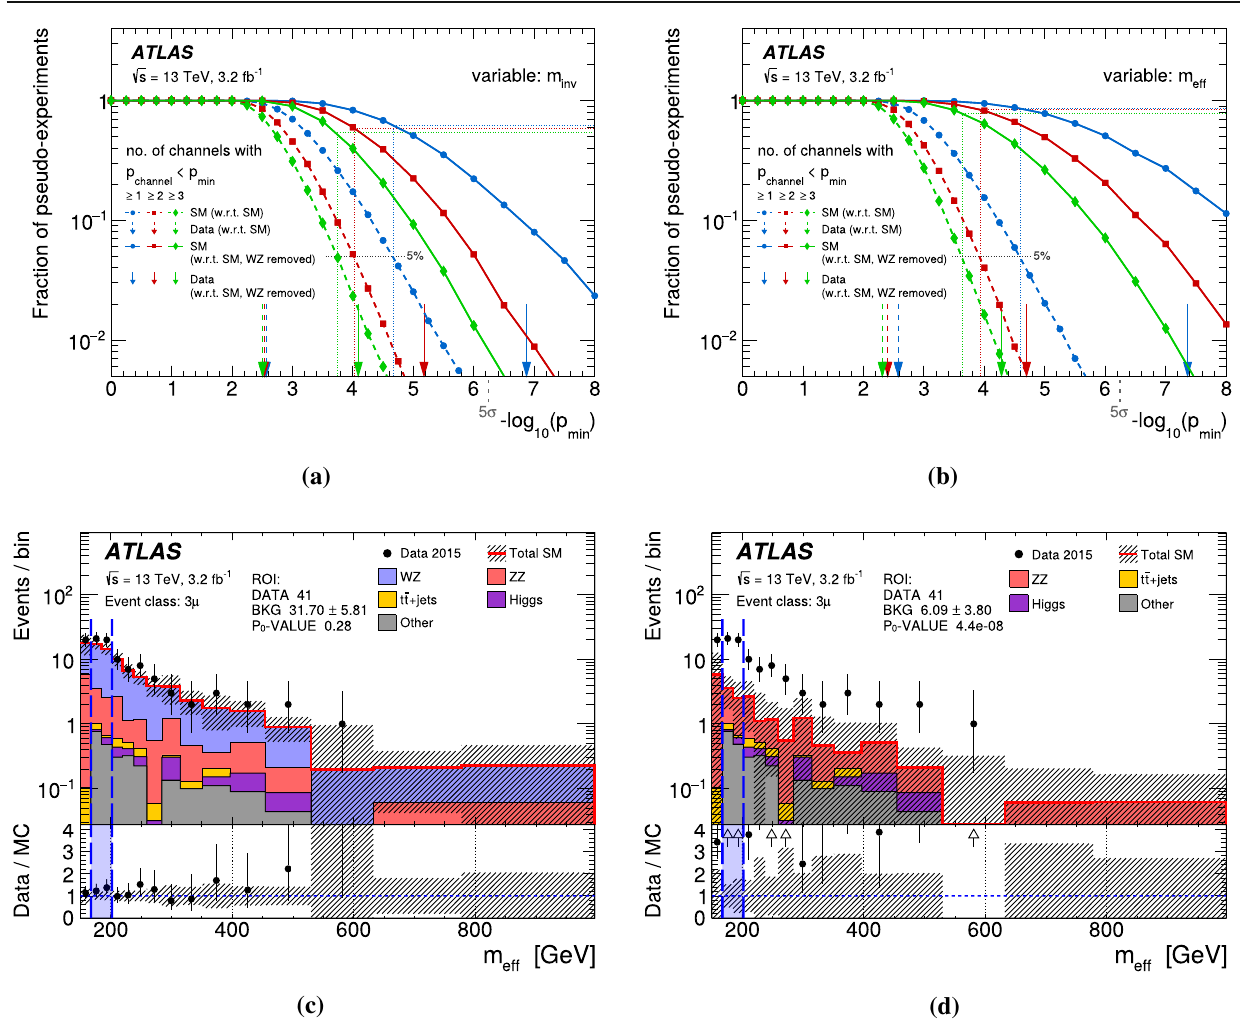
Fig. 6 The fraction of pseudo-experiments which have at least one, two and three p channel -values below a given p min , given for both the pseudo-experiments generated from the nominal SM expectation and tested against the nominal expectation (dashed) and for those tested against the modified expectation (‘SM, W Z removed’) in which the W Z diboson process is removed (solid). The m inv scan is shown in a and the m eff scan in b. The horizontal dotted lines show the fractions of pseudo-experimentsyielding P exp , i < 5%whentestedagainstthemod-